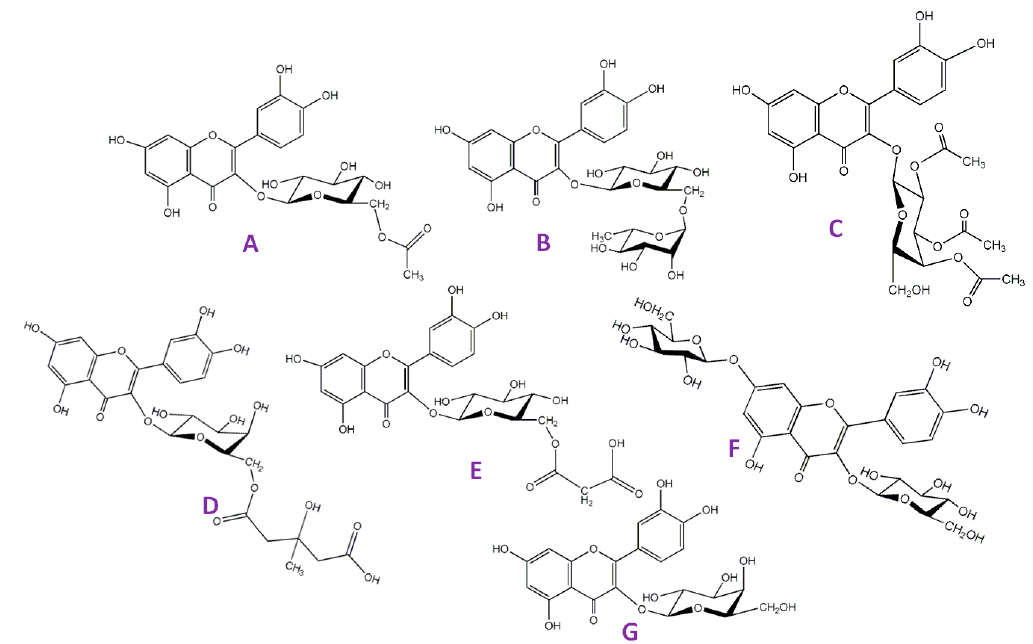
Figure 1. Different structures of Moringa oleifera chemical compounds, mainly quercetin glycosides showing different glycosylation pattern. ( A ) quercetin-acetylhexose; ( B ) quercetin-rutinoside; ( C ) quercetin-triacetylhexose; ( D ) quercetin-hydroxy-methylglutaroyl hexose; ( E ) quercetin-malonylhexose; ( F ) quercetin-dihexose; and ( G ) quercetin-hexose.